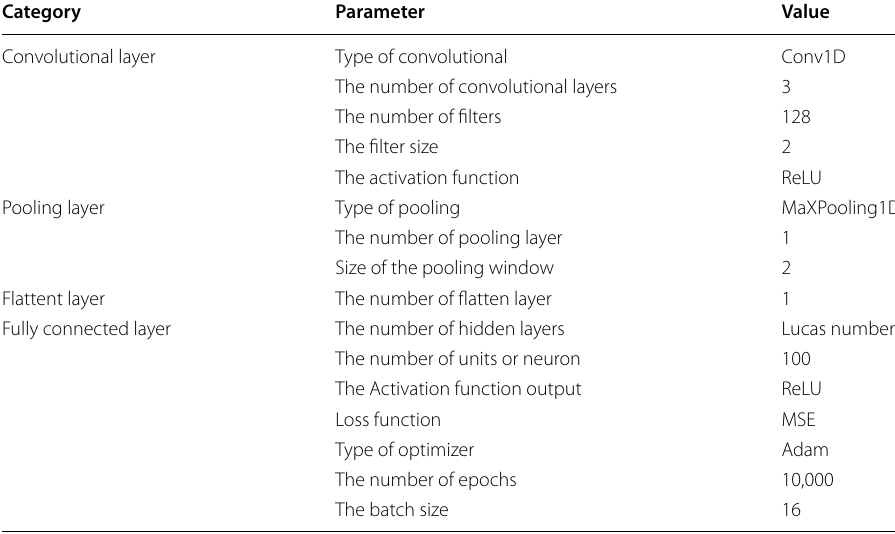
Table 4 The list of CNN forecast component parameters